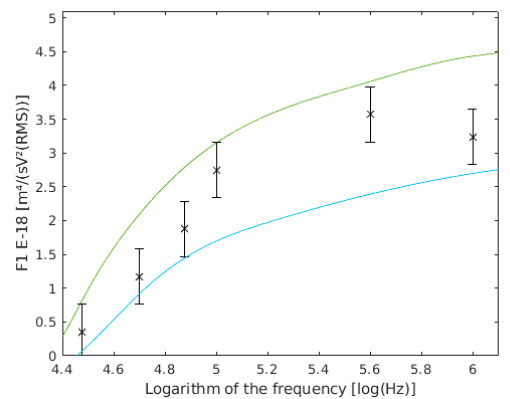
Figure 7. F 1 variation with the cell radius. F 1 with a 3.6 µ m cell radius are shown in green, and with a 2.9 µ m cell radius are shown in cyan, and the results of this work are the six frequency points with their confidence intervals drawn.